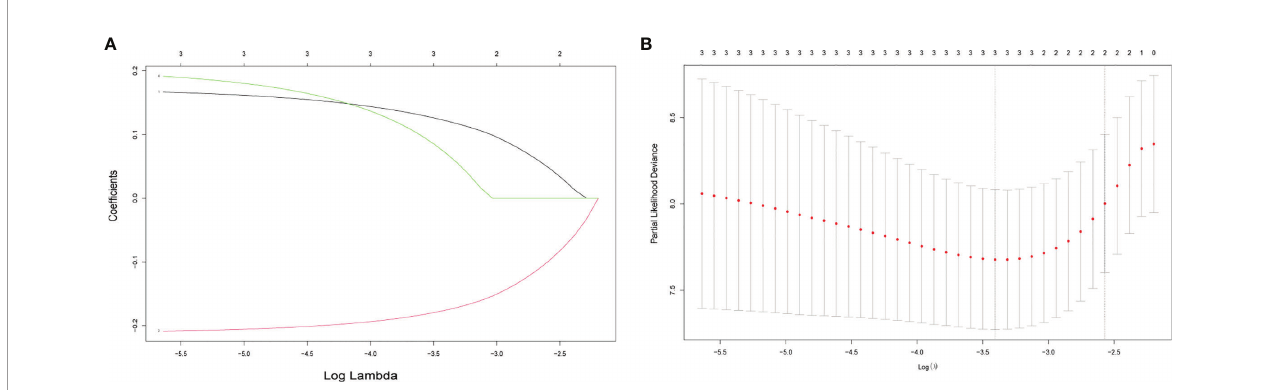
FIGURE 3 | Selecting exosome-related genes associated with patient prognosis by LASSO Cox regression analysis. (A) LASSO coef fi cient pro fi les of three genes with p < 0.01. (B) Tenfold cross-validations result which identi fi ed optimal values of the penalty parameter l